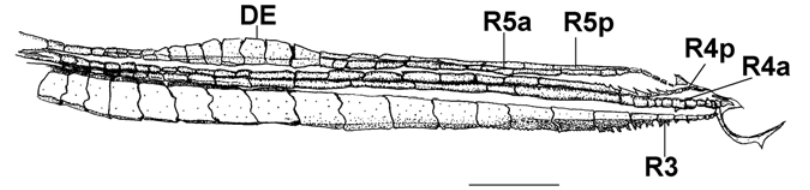
Fig. 6. Gonopodium tip of Cnesterodon iguape , MZUSP 54978. Bar 1 mm. DE = dorsal expansion. R3, R4a, R4p, R5a, R5p = gonopodial